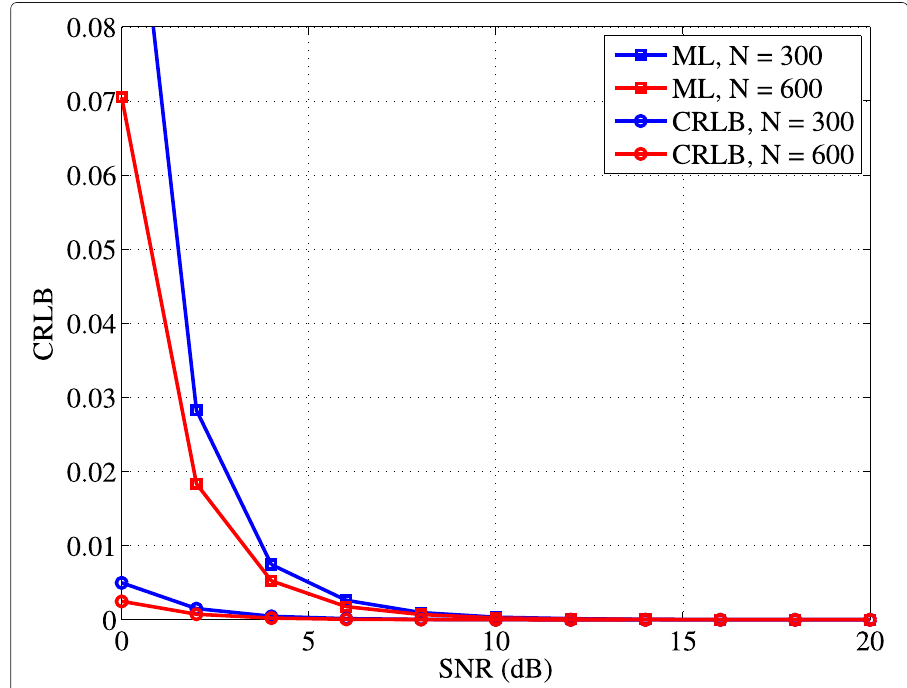
Fig. 3 The CRLB of the proposed algorithm. ML under N = 300, ML under N = 600, CRLB under N = 300, and CRLB under N = 600